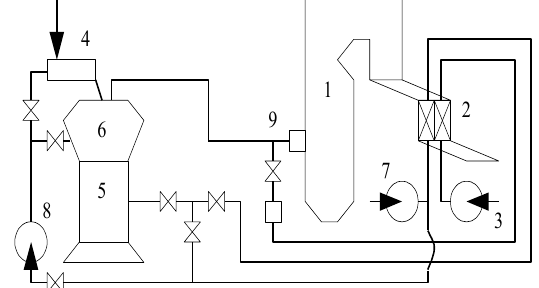
Fig.1 Schematic of a medium speed mill, positive- pressure, direct-fired pulverizing